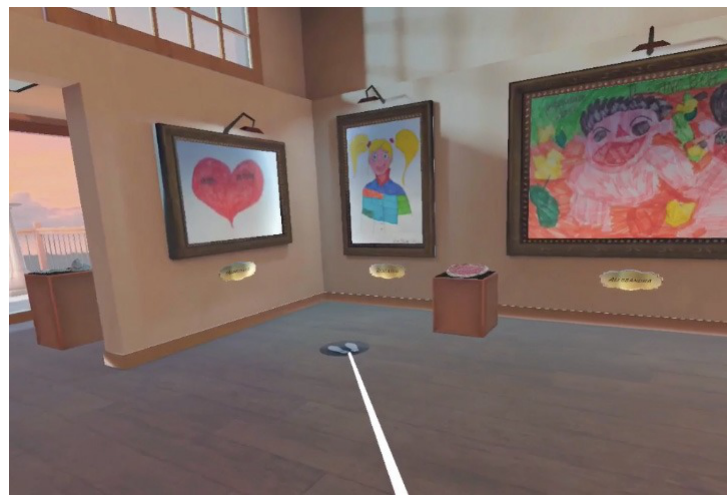
Figure 5. Virtual Museum navigation in